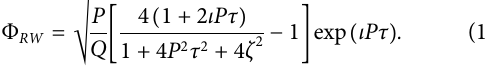
Frontiers in Physics |